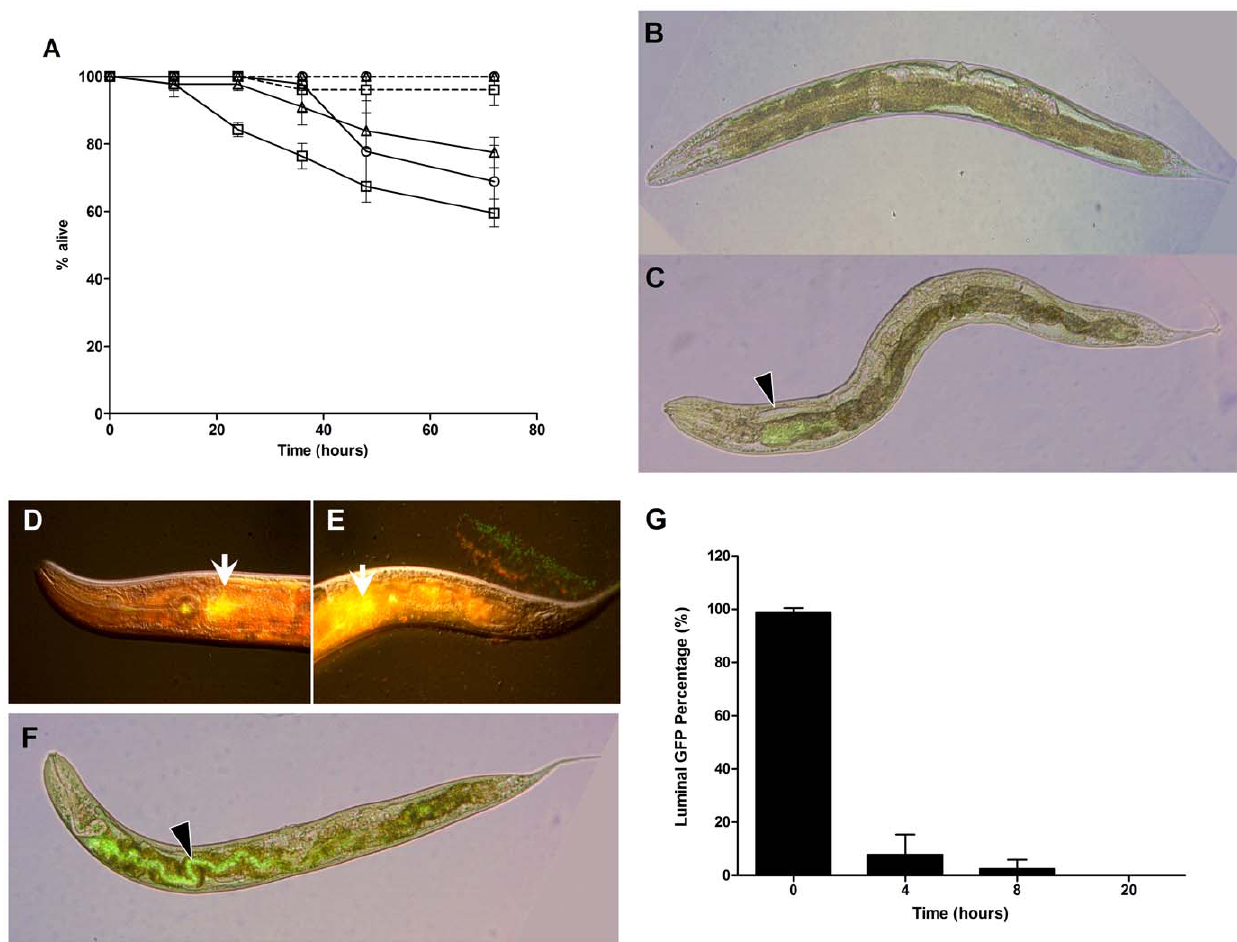
Figure 3. B.pseudomallei does not persistently accumulate within the C.elegans gut. (A) One-day old Glp worms fed with B. pseudomallei Human R15 (straight line) and E. coli OP50 (dashed line) for 4 hours (open triangles), 12 hours (open circles) and 20 hours (open squares) then shifted to E. coli OP50. Graph shows the mean 6 SD of three replicates (30 worms/replicate) from a representative of 3 independent experiments. (B and C) Representative N2 worm infected with R15-GFP. These merged images show bacterial green fluorescence at the anterior intestinal lumen (black arrow head). (B) 4 hours post-infection. (C) 24 hours post-infection. (D–E) Representative tnt-3(aj3) mutant worm infected with R15-GFP for 6 hours and transferred to E. coli OP50. These merged images show bacterial fluorescence (green channel) (black arrow head) and the auto-fluorescence (red channel) (white arrow). (D) 2 hours post-shifting at the anterior intestine (E) 2 hours post-shifting at the posterior intestine. (F) Representative fully colonized tnt-3(aj3) mutant worm infected with R15-GFP. These merged images show bacterial green fluorescence at the anterior intestinal lumen (black arrow head). (G) Ingested R15-GFP was eradicated from the worm gut via defecation within a short period of time upon transfer to OP50 lawn. Columns represent mean 6 SEM from two independent experiments.